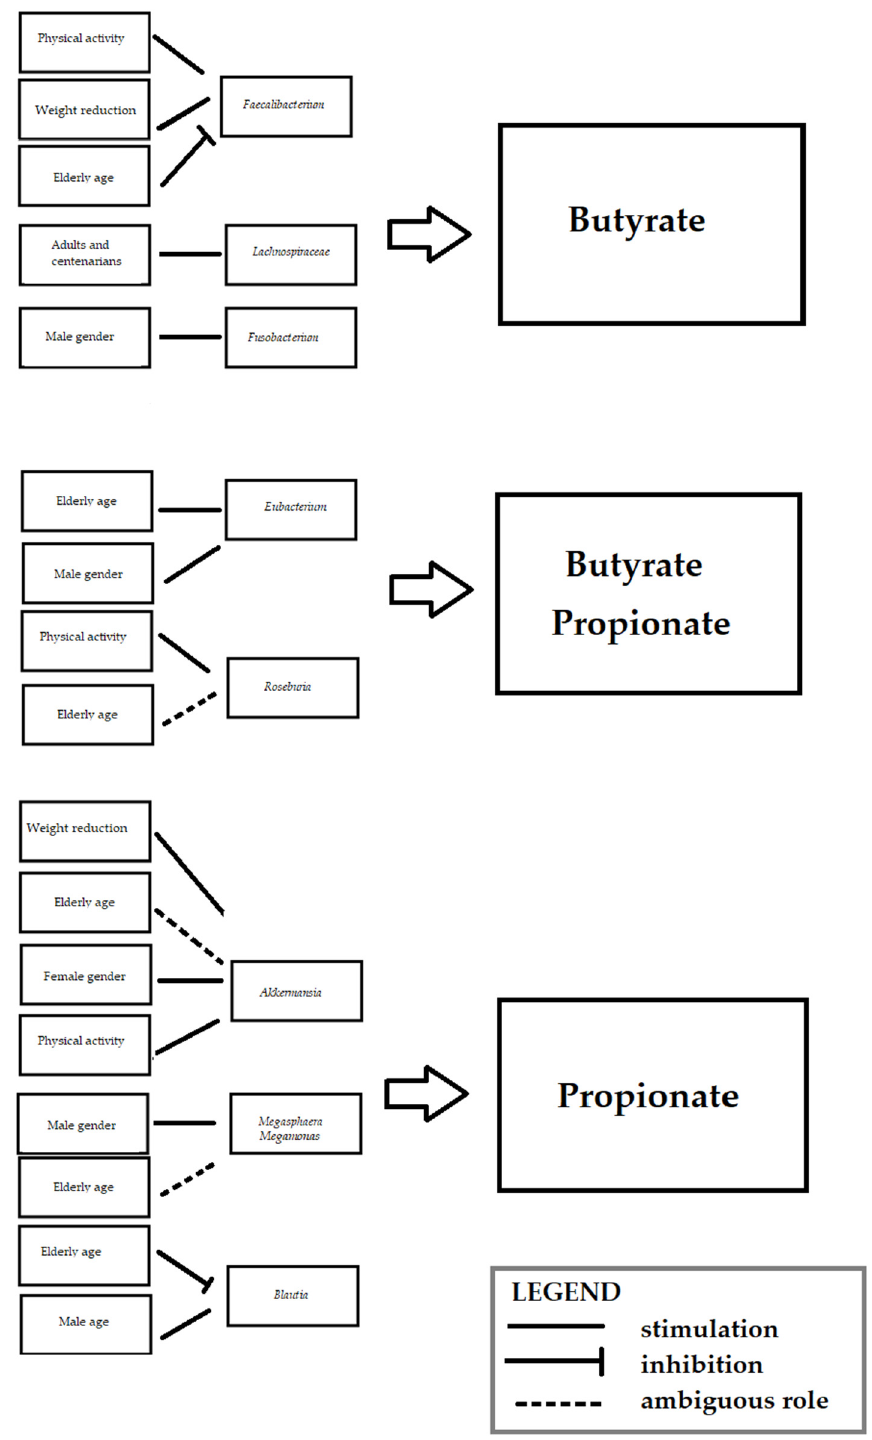
Figure 2. Short-chain fatty acid production potential of listed bacteria and their association with particular cardiovascular risk factors.